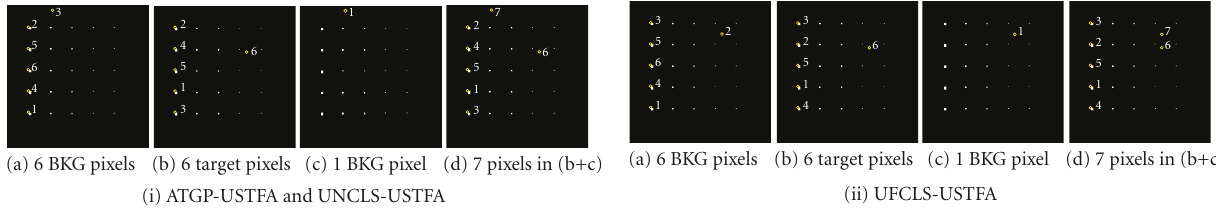
Figure 4: Target pixels extracted by three unsupervised algorithms ATGP-USTFA, UNCLS-USTFA, and UFCLS-USTFA for scenario TI.